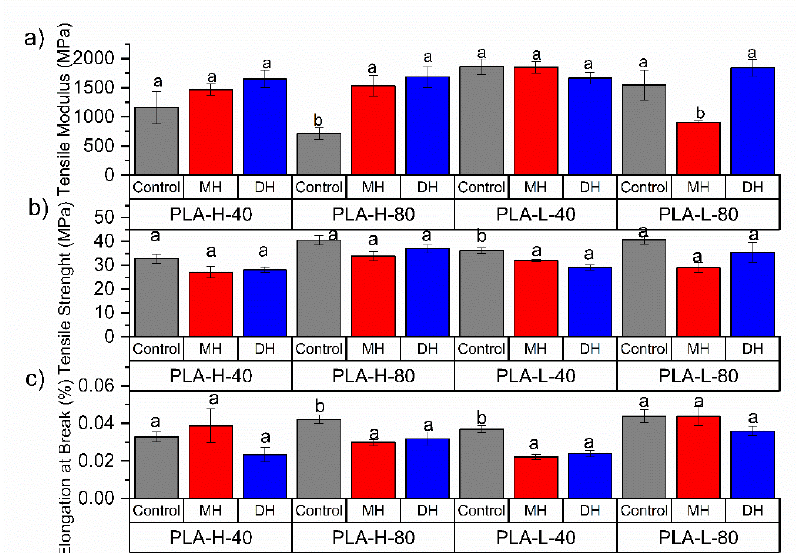
Figure 2. Change in the tensile test properties of the FDM dumbbells due to the DH or MH steriliza- tion process as measured in the PLA 3D-printed samples: ( a ) Tensile Modulus, ( b ) Tensile Strength and ( c ) elongation at break. Grey bar: control sample; blue bar: dry heat sterilization; and red bar: moist heat sterilization. a,b Different letters show statistically significant differences between formulations ( p < 0.05).